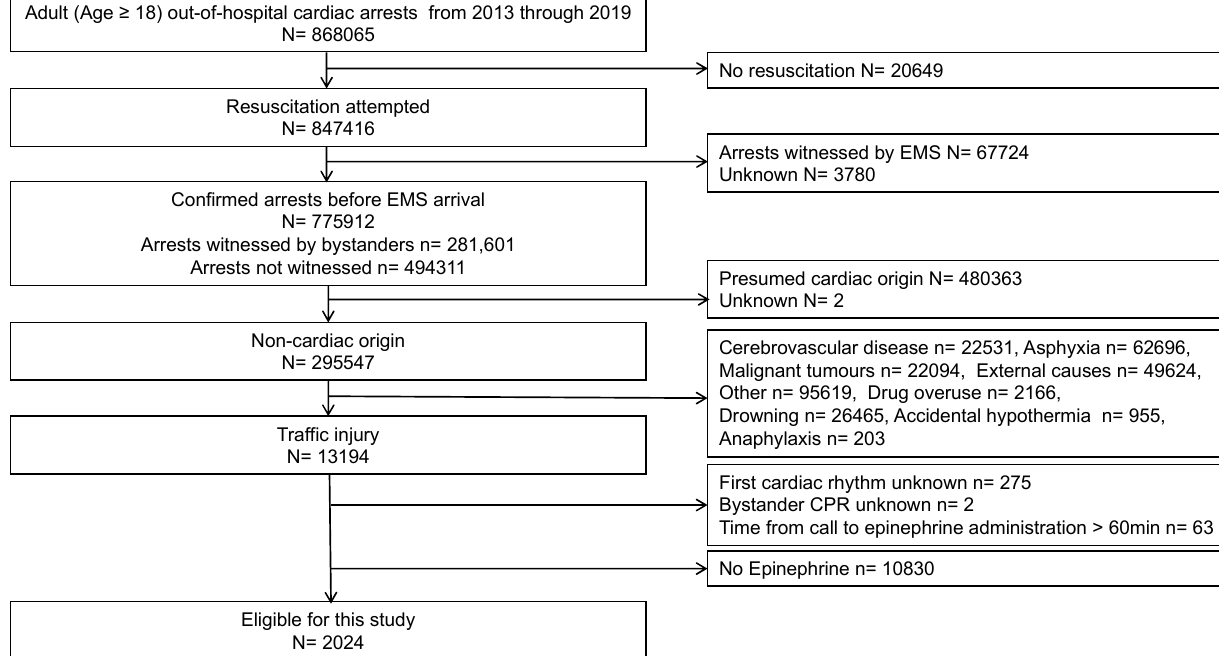
Figure 1. The patient selection flow chart. EMS, emergency medical services.